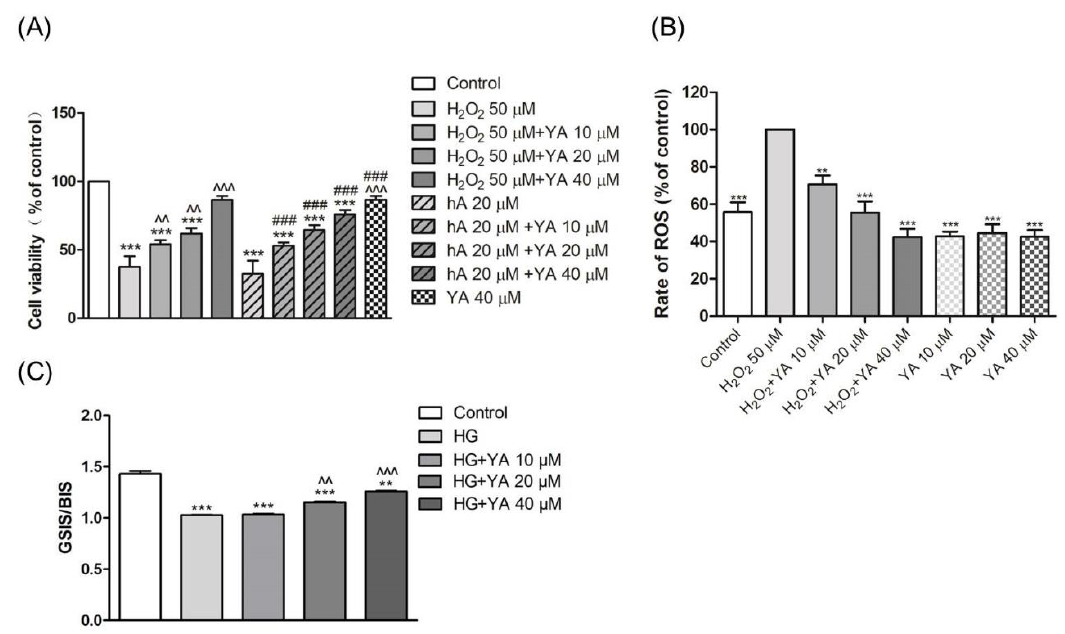
Figure 3. Antioxidant activity of YA in INS-1 cells. ( A ) The effect of YA on the toxicity of H 2 O 2 and hA in INS-1 cells. INS-1 cells were treated with H 2 O 2 (50 µ M), co-incubation of H 2 O 2 (50 µ M) and YA (10, 20, and 40 µ M), hA (20 µ M), co-incubation of hA (20 µ M) and YA (10, 20, and 40 µ M), and YA (40 µ M) alone for 24 h. Cell viability was measured using an MTT viability assay. (*** p < 0.001 vs. Control; ˆˆ p < 0.01 vs. H 2 O 2 ; ˆˆˆ p < 0.001 vs. H 2 O 2 ; ### p < 0.001 vs. hA); ( B ) Effect of YA on reactive oxygen species (ROS) accumulation in INS-1 cells. INS-1 cells were treated with H 2 O 2 (50 µ M) or YA (10 µ M, 20 µ M, 40 µ M) for 24 h. The DCFH-DA method was used to assay the rate of ROS. (** p < 0.01 vs. H 2 O 2, *** p < 0.001 vs. H 2 O 2 ); ( C ) Effect of different concentrations of YA on GSIS/BIS levels in INS-1 cells cultured by medium with 40 mM glucose. INS-1 cells were plated in a 96-well plate overnight and then treated with either glucose (40 µ M) or co-incubation of glucose (40 µ M) and YA (10 µ M, 20 µ M, 40 µ M) for 24 h. (** p < 0.01 vs. glucose, *** p < 0.001 vs. glucose). All data